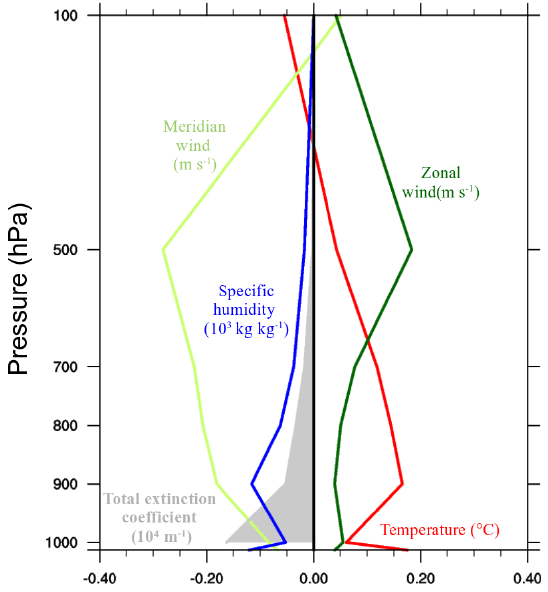
Figure 16. Vertical profile, obtained by the difference between SSP585 and SSP585cst simulations, of the temperature ( ◦ C), the to- tal extinction coefficient (10 4 m − 1 ), the meridional and zonal wind (ms − 1 ) and the specific humidity (10 3 KgKg − 1 ) over the Iberian Peninsula for the months of June, July and